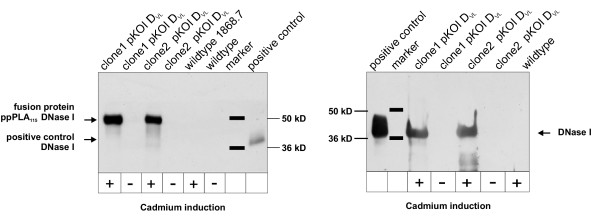
Expression of knock in target. Western blots show expression of recombinant human DNase I: Only transformed and heavy metal induced cells (+) show strong signals due to anti-DNase I antibodies. The intracellular PLA1-DNase-fusion protein is visualized on the left blot by samples of cell lysates. Bands are running at higher molecular weight than the mature and processed positive control due to the pre/pro-peptide. On the right, supernatants were subjected to Western blot; the size of the secreted protein of T. thermophila argues for a correct processing when compared to the positive control.